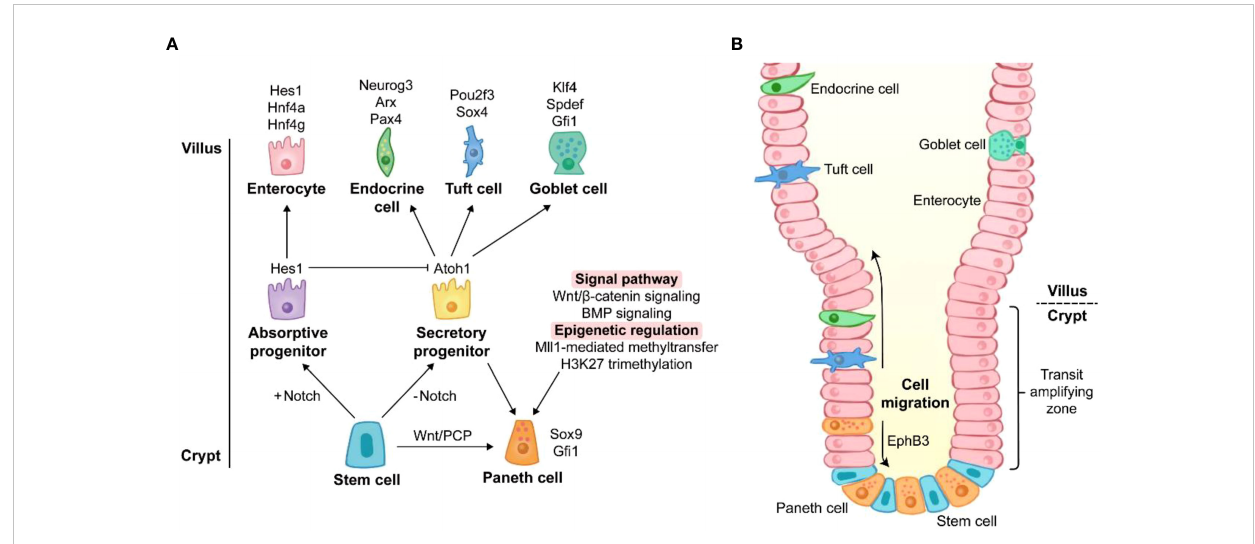
FIGURE 1 The origin of Paneth cell life. (A) Differentiation of Paneth cells. The differentiation towards secretory cells occurs when Notch signaling is off. Sox9 and G fi 1 are two key transcription factors of Paneth cell lineage. Wnt/PCP signaling directly drives the conversion of intestinal stem cells to Paneth cells. Wnt/ b -catenin signaling and BMP signaling promote the lineage commitment of Paneth cells. Recent studies have reported that the differentiation of Paneth cells is also affected by epigenetic regulation such as Mll1-mediated methyltransfer and H3K27 trimethylation. The genes around the cell images are key transcription factors for the cell lineage commitment. (B) Migration of Paneth cells. Unlike other secretory cells, Paneth cells are located at the base of crypts. After differentiation, Paneth cells migrate downward to crypt bottom, and they are intercalated between stem cells. The migration of Paneth cells is mediated by